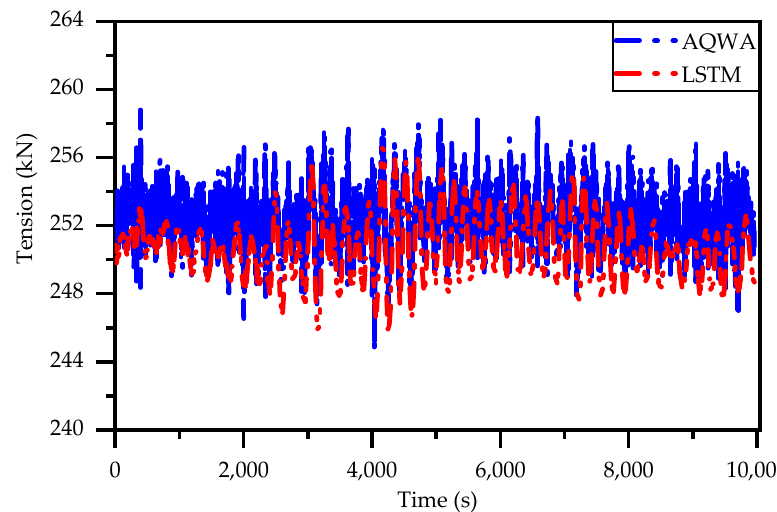
Figure 7. Error analysis of AD10 Mooring Line 8.